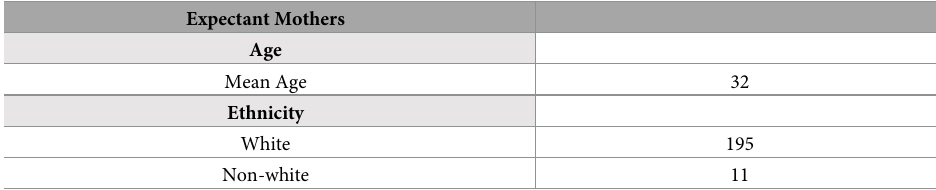
Table 1. Demographics of expectant mothers completing the